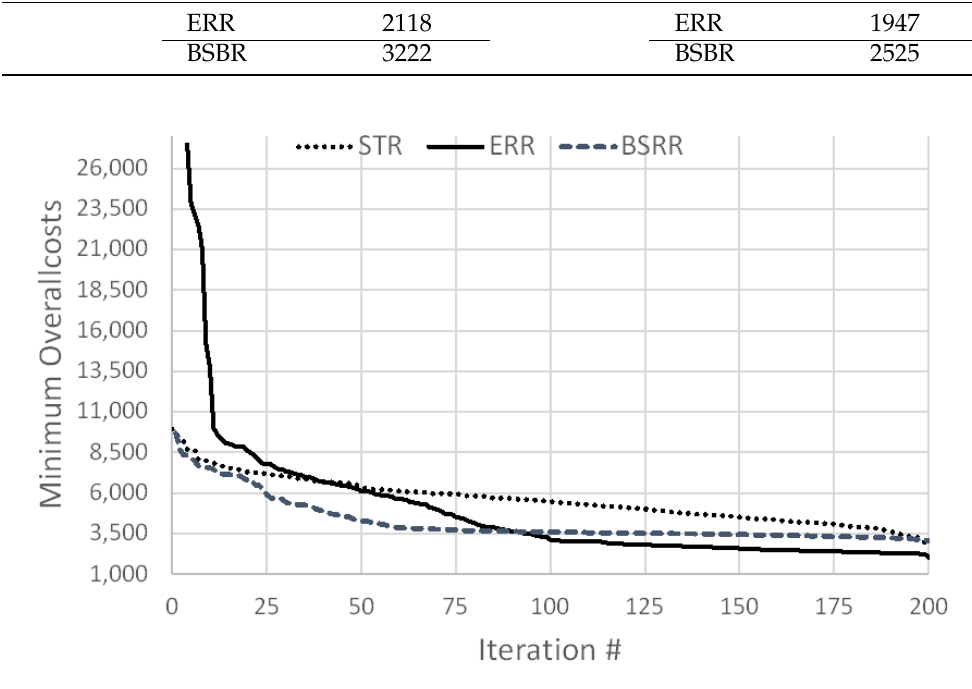
Figure 2. Minimum overall cost per simheuristic version for all MRP planning